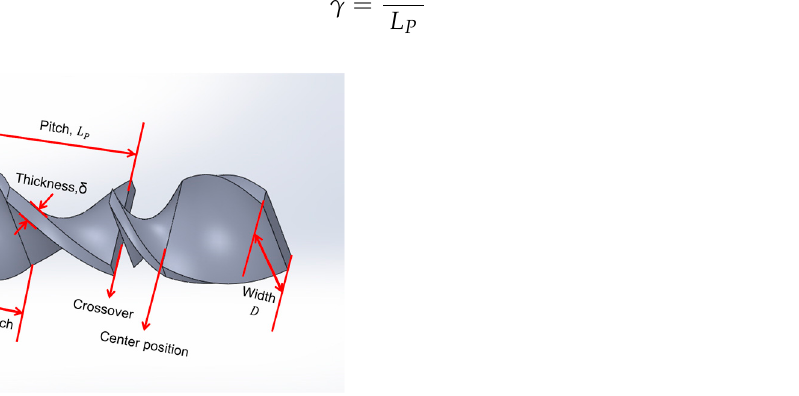
Figure 2. the structure of the mixer and corresponding geometric parameters. Figure 2. The structure of the mixer and corresponding geometric